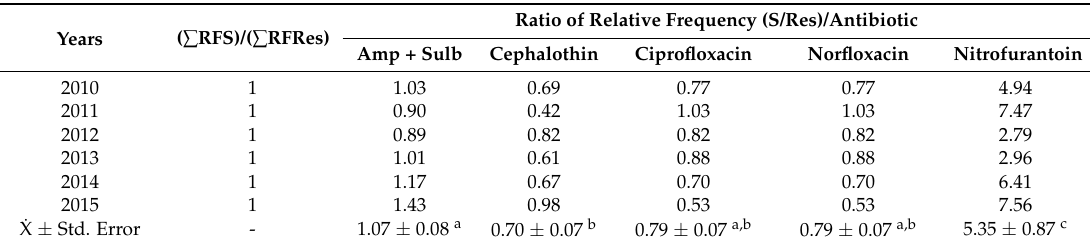
Table 2. Ratio of the relative frequencies of susceptibility and resistance in urocultures positive for E. coli from outpatients, 2010–2015.